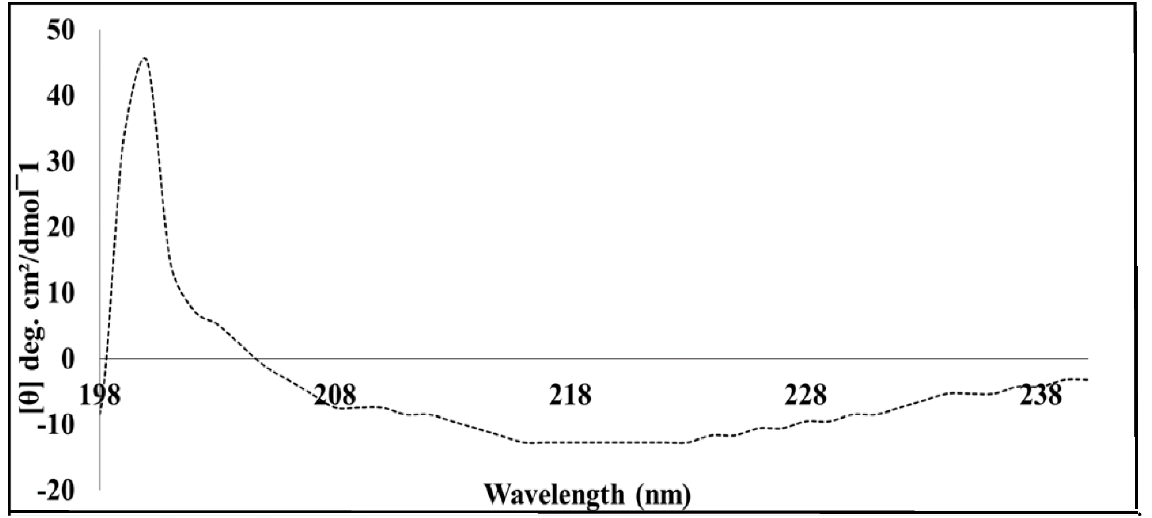
Figure 2. A 12% SDS–PAGE gel showing the elution fractions of MP from an IMAC column before refolding. Mw: unstained molecular weight marker protein standards. Lanes Sol p: protein fraction after solubilisation with 4 M urea; FT: flow-through fraction; W1: wash fraction 1; W2: wash fraction 2; W3: wash fraction 3; E1: protein elution fraction 1; E2: protein elution fraction 2; E3: protein elution fraction 3; E4: protein elution fraction 4.